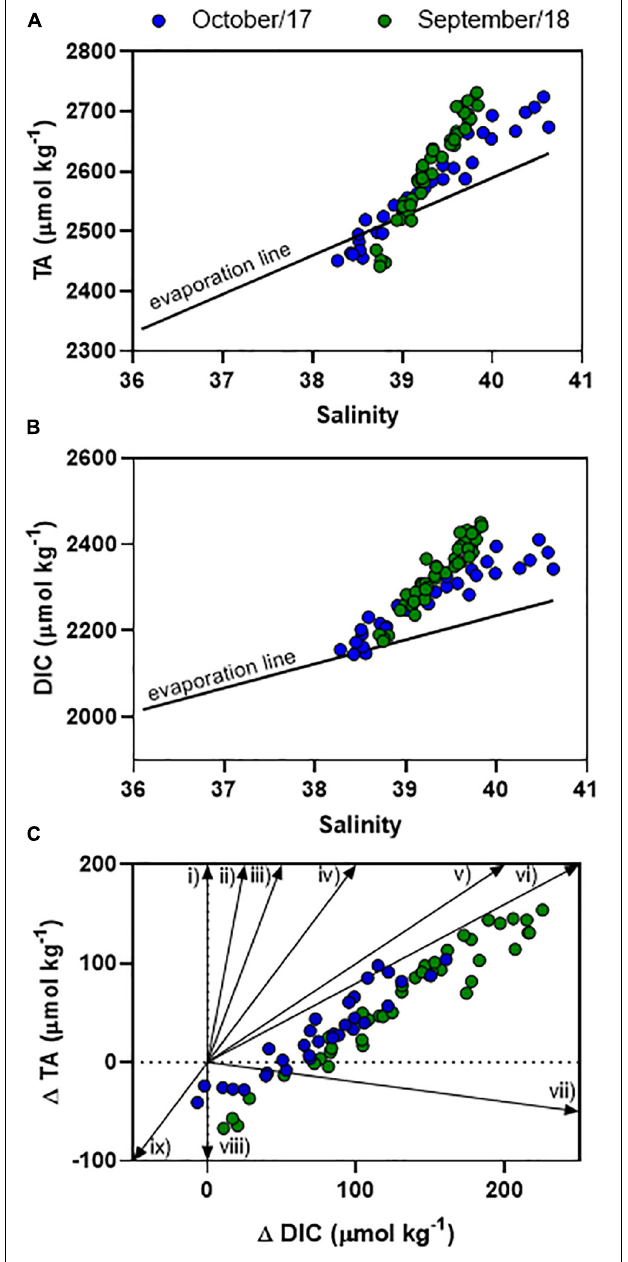
FIGURE 5 | Distributions of TA (A) and DIC (B) concentrations as a function of salinity. The graph (C) represents the deviation of TA and DIC from conservative mixing following specific vectors of organic matter degradation, which are: (i) ammonification, (ii) iron reduction, (iii) manganese reduction, (iv) carbonate dissolution, (v) sulfate reduction, (vi) denitrification, (vii) aerobic respiration, (viii) sulfur oxidation, iron oxidation, and nitrification, (ix) carbonate